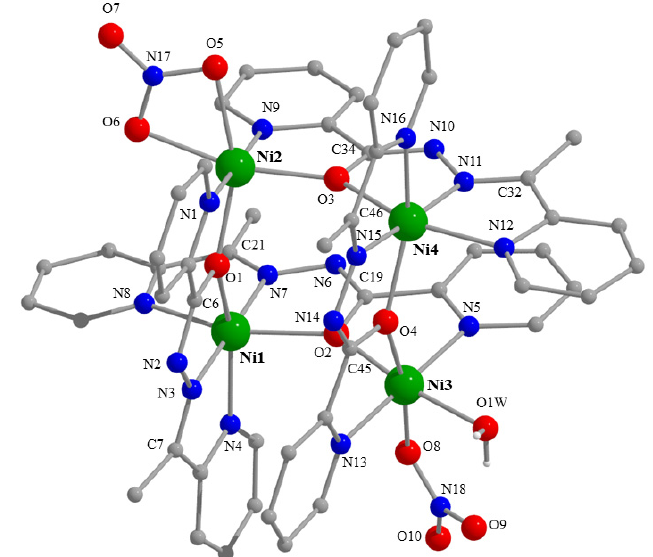
Figure 3. Partially labelled plot of the structure of the cation [Ni 4 (NO 3 ) 2 (L) 4 (H 2 O)] 2+ that is present in the.crystal structure of 2· 0.2H 2 O·3EtOH. A plot with thermal ellipsoids is presented in Figure S19.